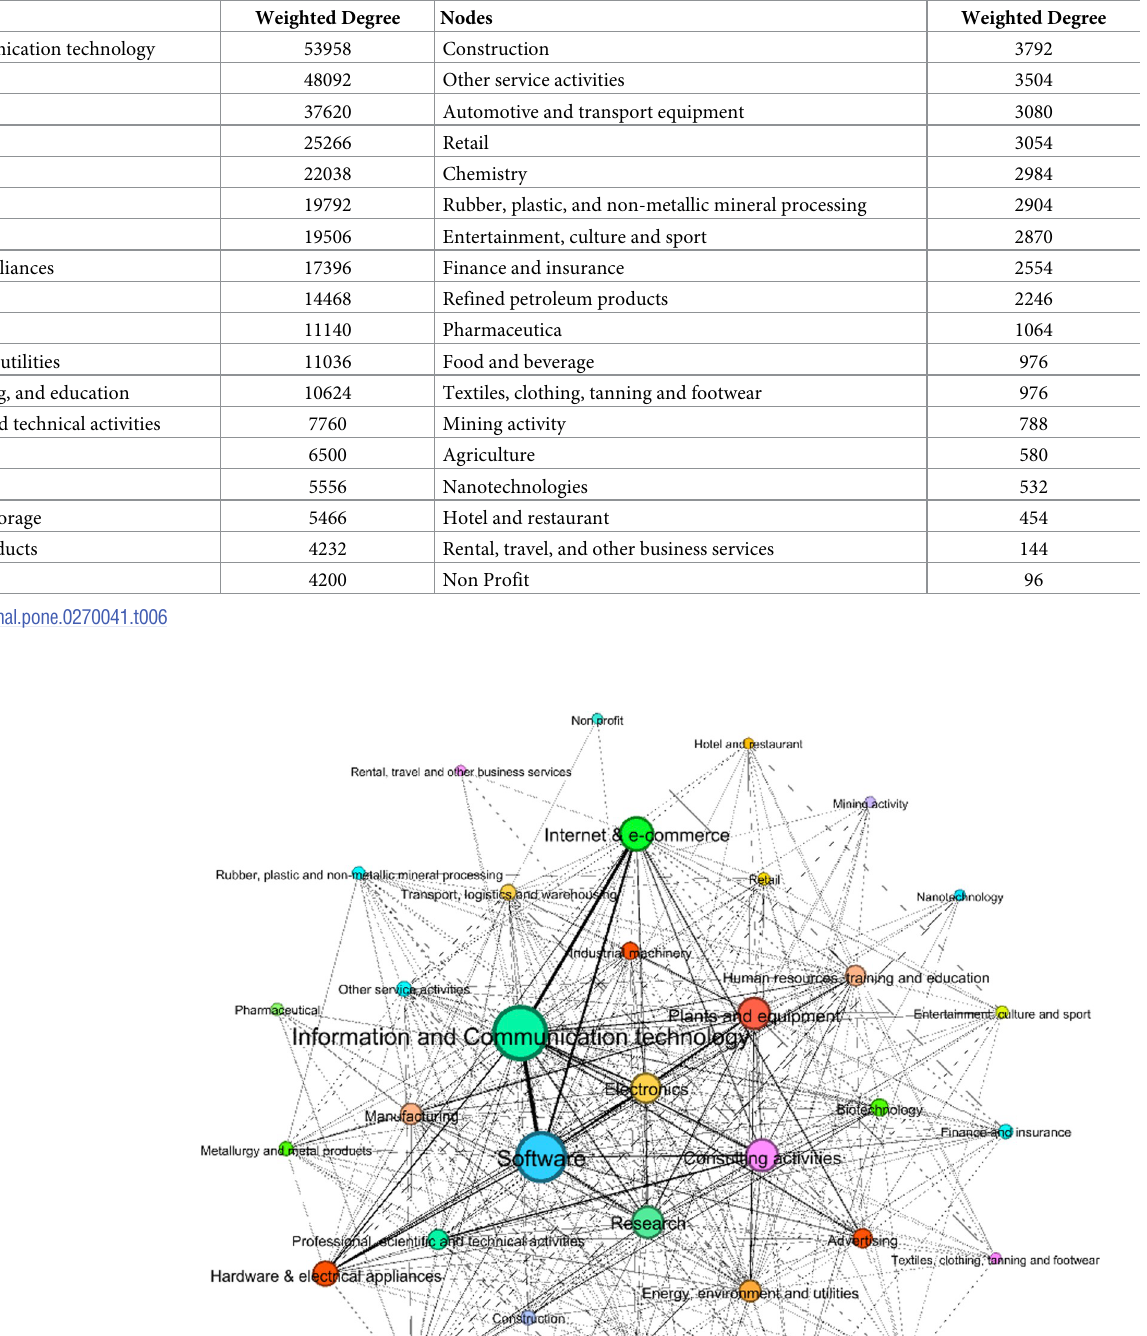
Table 6. The centrality of sectors based on the co-occurrence of specializations (weighted degree).